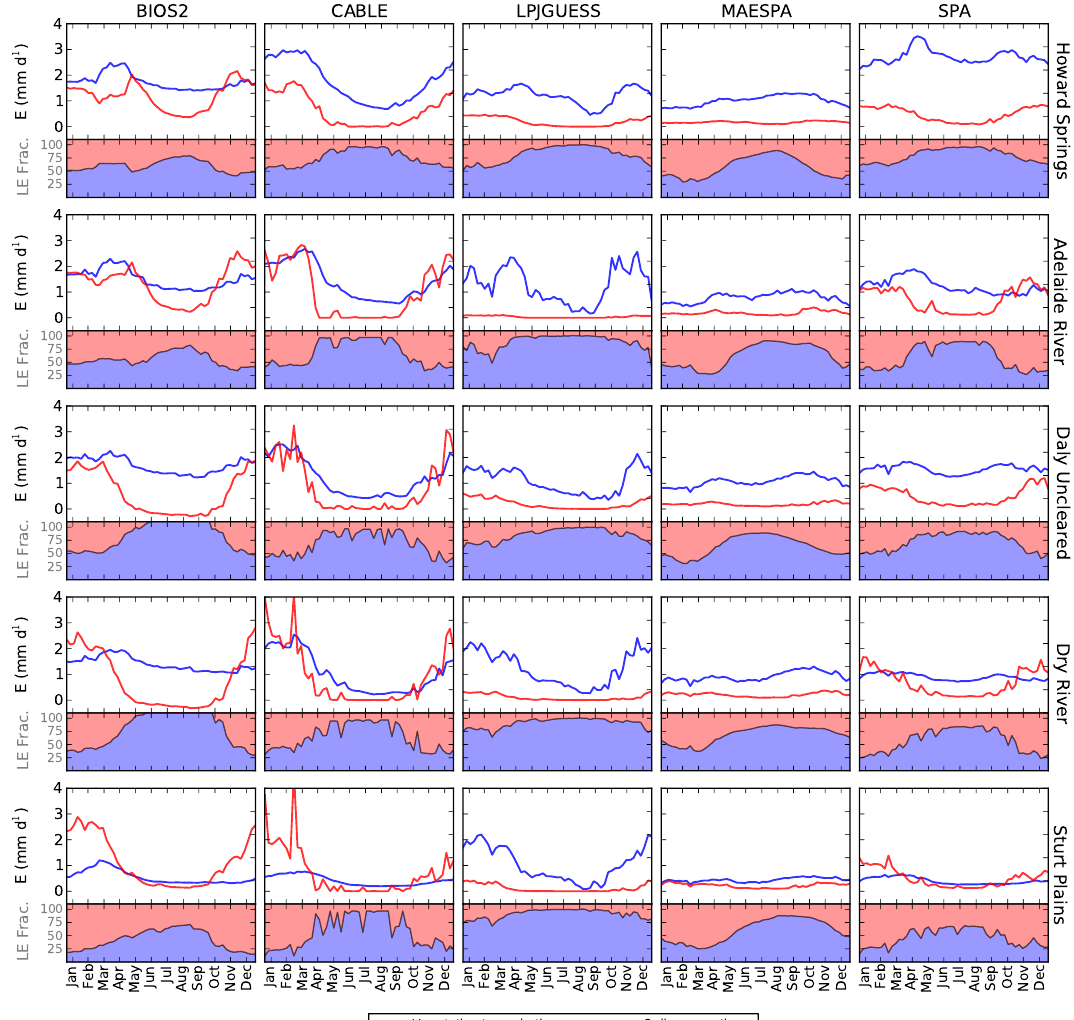
Figure 6. Average year outputs of vegetation transpiration (grass + trees) and soil evaporation, as well as their percentage contributions to total latent energy (LE) for each of the six terrestrial biosphere models at each of the five savanna